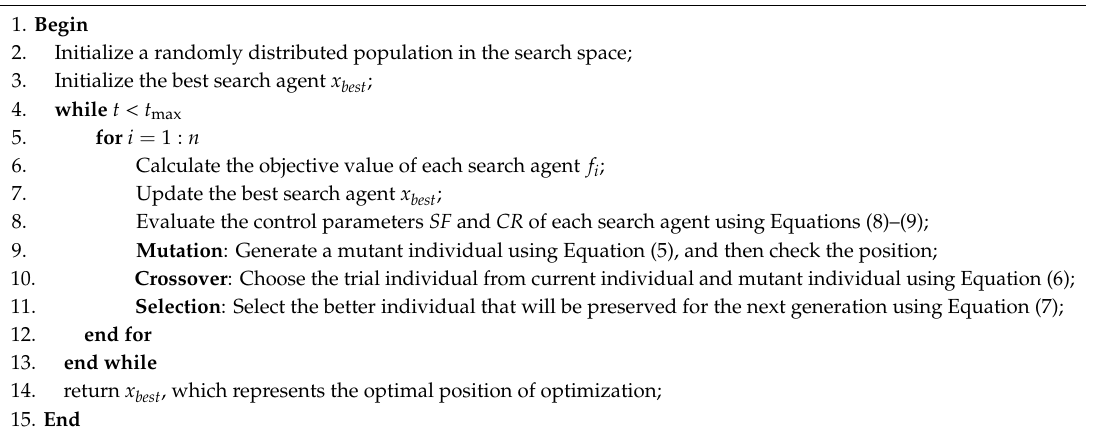
Figure 2. ( a ) The average value of crossover rate ( CR ) and ( b ) scaling factor ( F ) for 30 runs using jDE algorithm. Algorithm 2 Pseudocode of jDE algorithm for an optimization problem